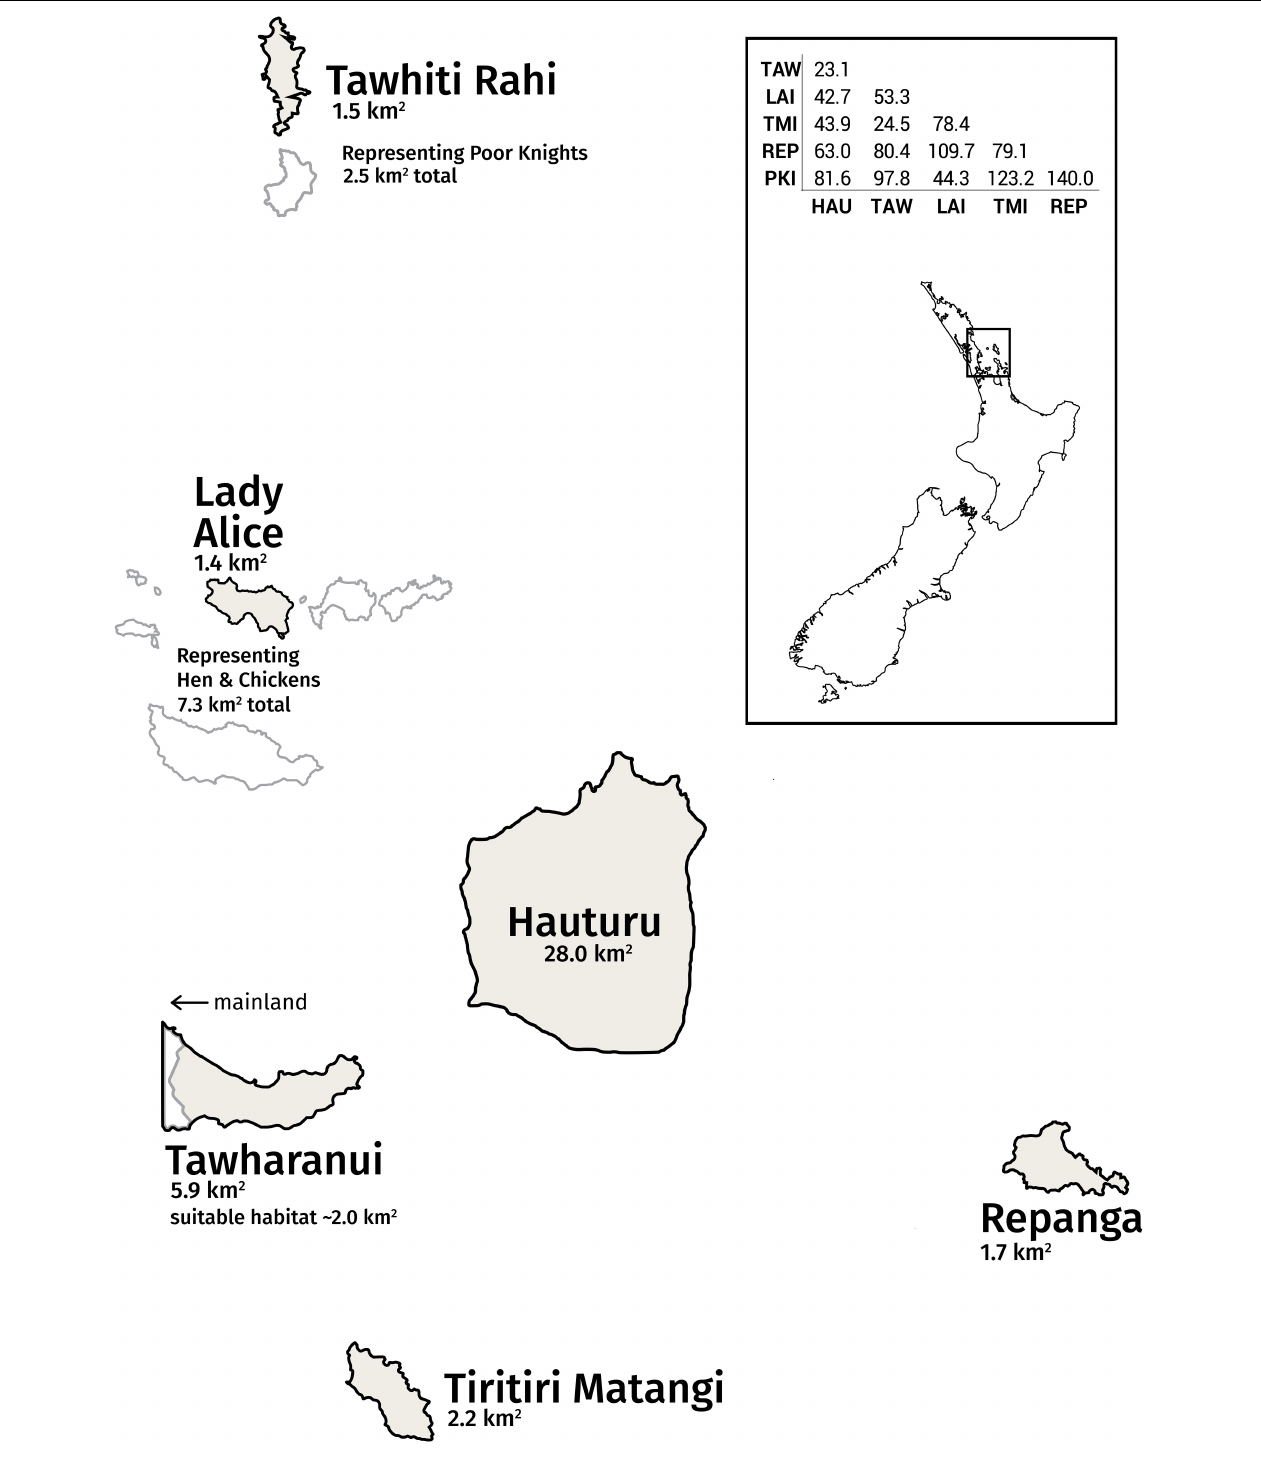
FIGURE 1 | Simplified map of the Hauraki Gulf archipelago, home to a metapopulation of bellbirds. Tawhiti Rahi represents the Poor Knights Islands group; likewise, Lady Alice Island represents the Hen and Chickens Islands group. The other islands of these wider groups are shown in white. The distance matrix between sites (measured in km) is provided (HAU, Hauturu; TAW, Tawharanui; LAI, Lady Alice; TMI, Tiritiri Matangi; REP, Repanga, PKI, Tawhiti Rahi). Distances are not to scale on simplified map.